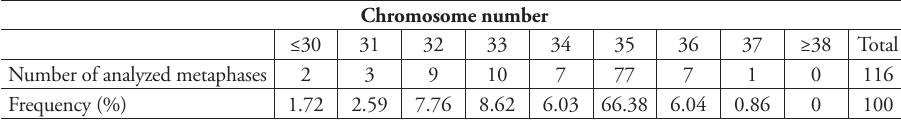
Table 1. Chromosome number of hybrids ( C. farreri ♀ × A. i. irradians ♂